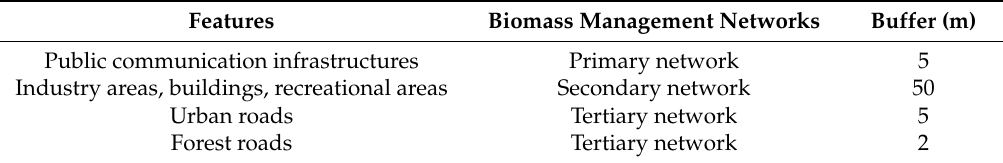
Table 2. Legal buffer distances for the different forest biomass management networks and features. 150